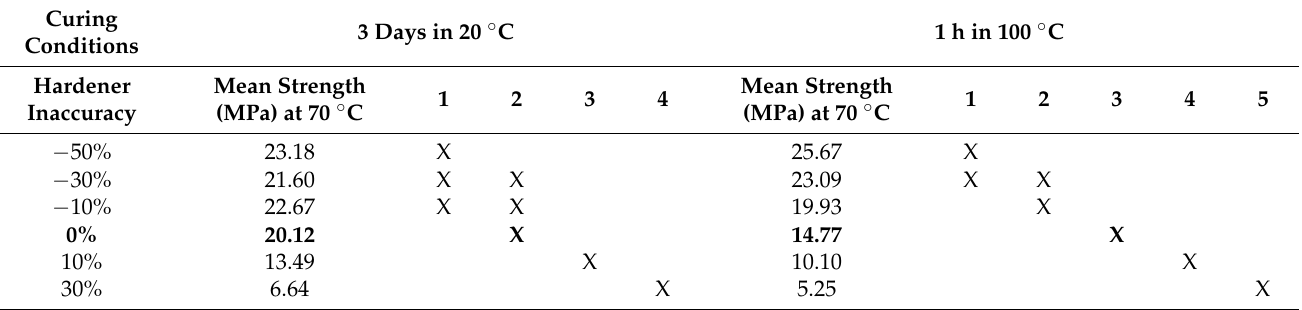
Table 2. Homogeneous groups (1-2-3-4, 1-2-3-4-5) of strength at 70 ◦ C for joints made with Hysol 9492.